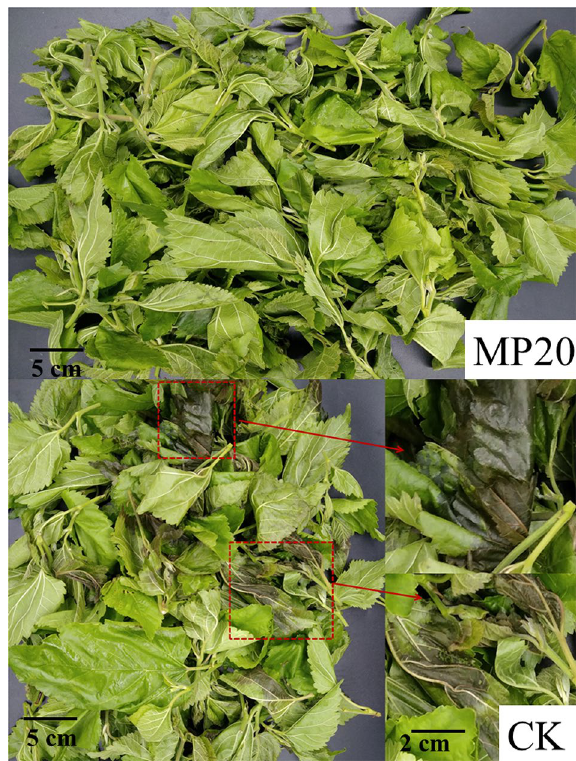
Figure 1. Effect of packaging on respiration rate of mulberry leaf vegetable during storage. Error bars indicate standard deviation. Asterisks indicate significant differences at the same storage time ( p < 0.05).